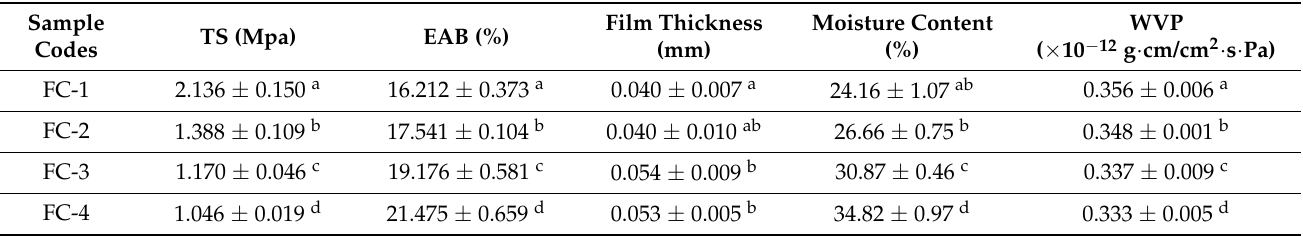
Table 2. Tensile strength, elongation at break, thickness, moisture content, and water vapor perme- ability of the CS–SA-based edible